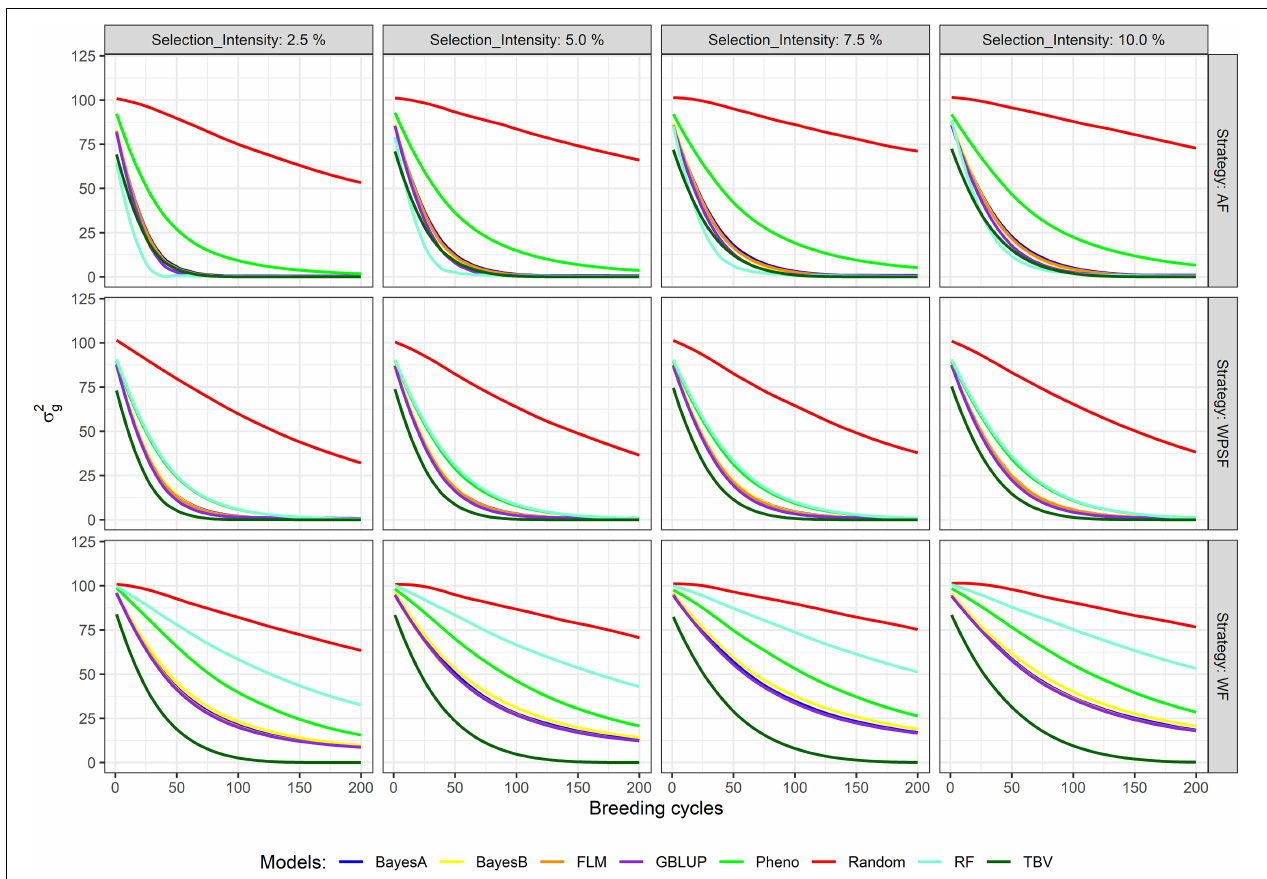
FIGURE 4 | Genetic variance across 200 breeding cycles. Colors correspond to the different selection methods, grid columns represent the selection intensities (2.5, 5, 7.5, and 10%), and grid rows represent the breeding strategies, where individuals are selected across family (AF), within pre-selected families (WPSF), or within family